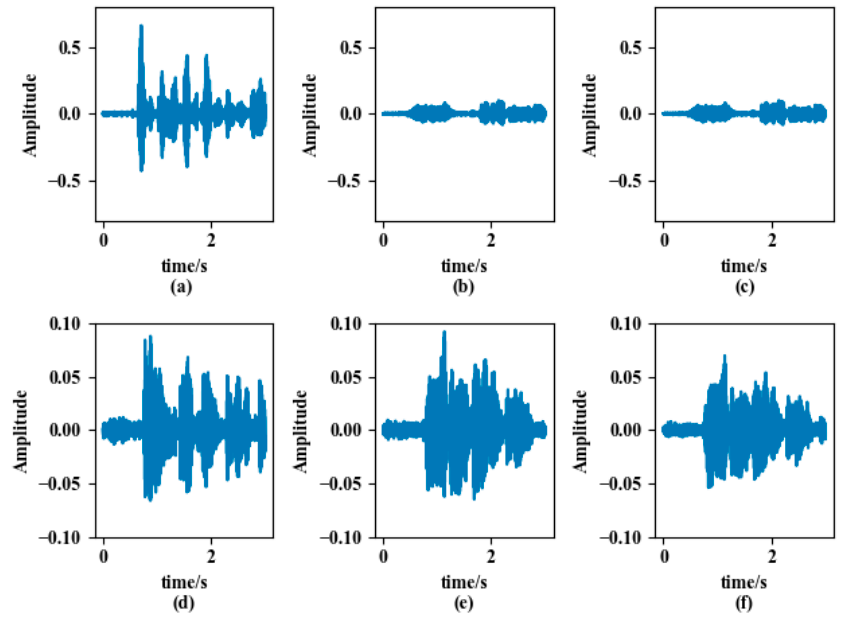
Figure 2. Two categories of emotional speech and Mix-wav-enhanced speech. ( a , b ) are the emotional speech waveforms of two neutral categories, ( c ) is the audio waveform enhanced with Mix-wav, where λ is 0.9660, so the generated speech ( c ) comes from ( a ) has more ingredients. ( d – f ) are the emotional speech of the sad category, using the same